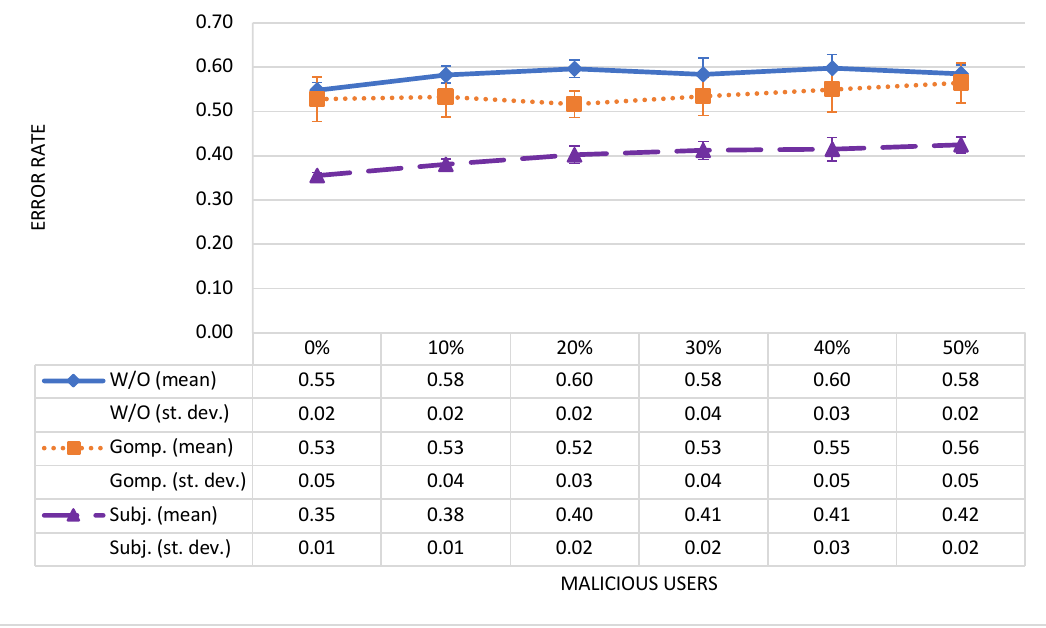
Figure 3. Mean value and Standard Deviation for error rate achieved with different methods for simulation configurations with different percentages of malicious